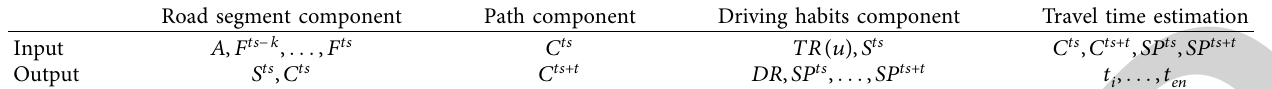
Table 2: The input and output of the